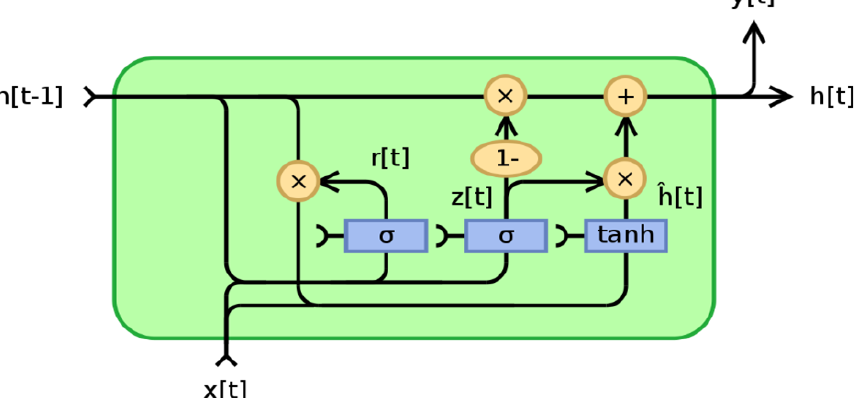
Figure 10. illustrate Gated Recurrent